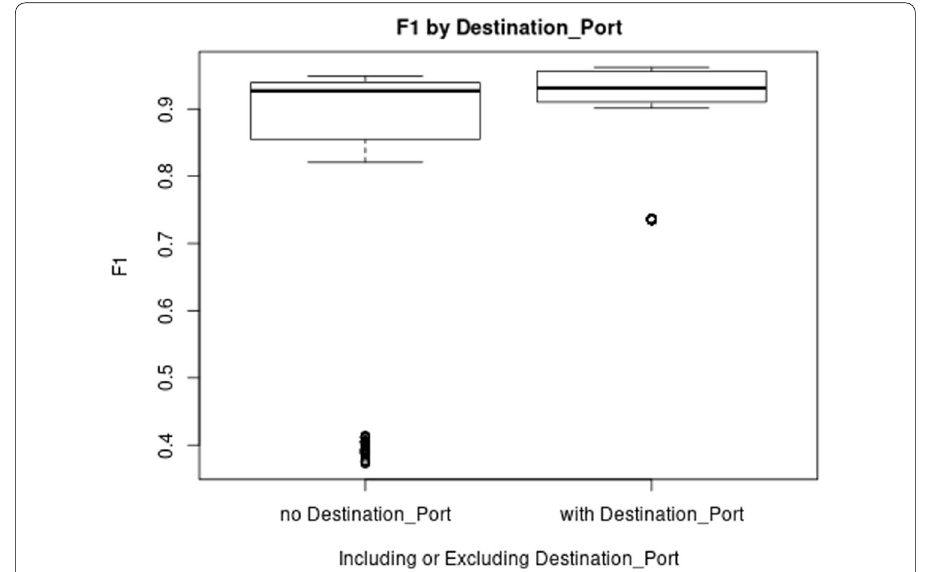
Fig. 12 Box plots of F1-score grouped by whether the dataset contains the Destination Port feature; Tukey’s HSD test indicates including Destination Port produces significantly different